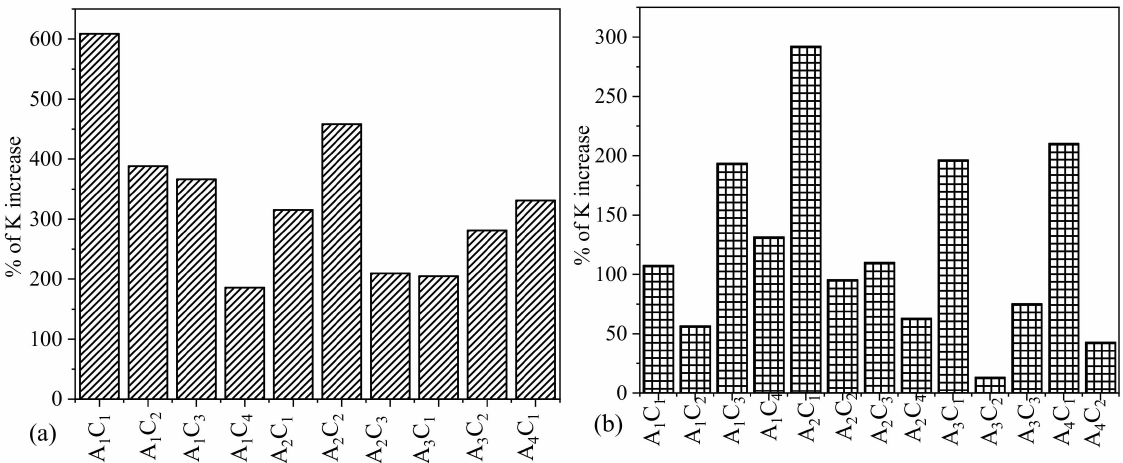
Figure 7. Percentage of K (viscosity at 1.0 s − 1 shear rate) increase of compositions having ( a ) 1% TO-NFC compared to 0.01% TO-NFC and ( b ) 0.5% TO-NFC compared to 0.005%